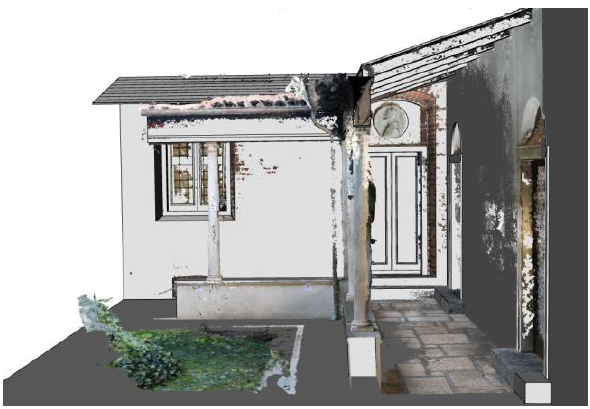
Figure 7. Mathematical reconstruction starting from the mesh white walls, reserving the possibility to improve the survey